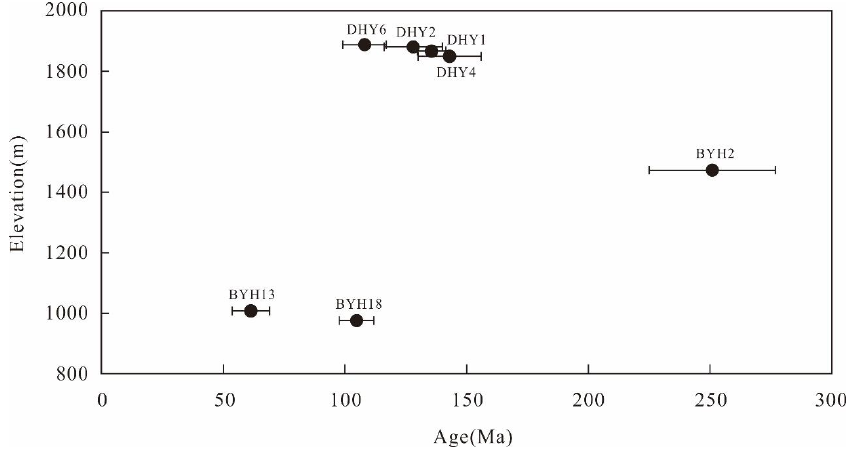
Figure 5. Apatite fission track age versus